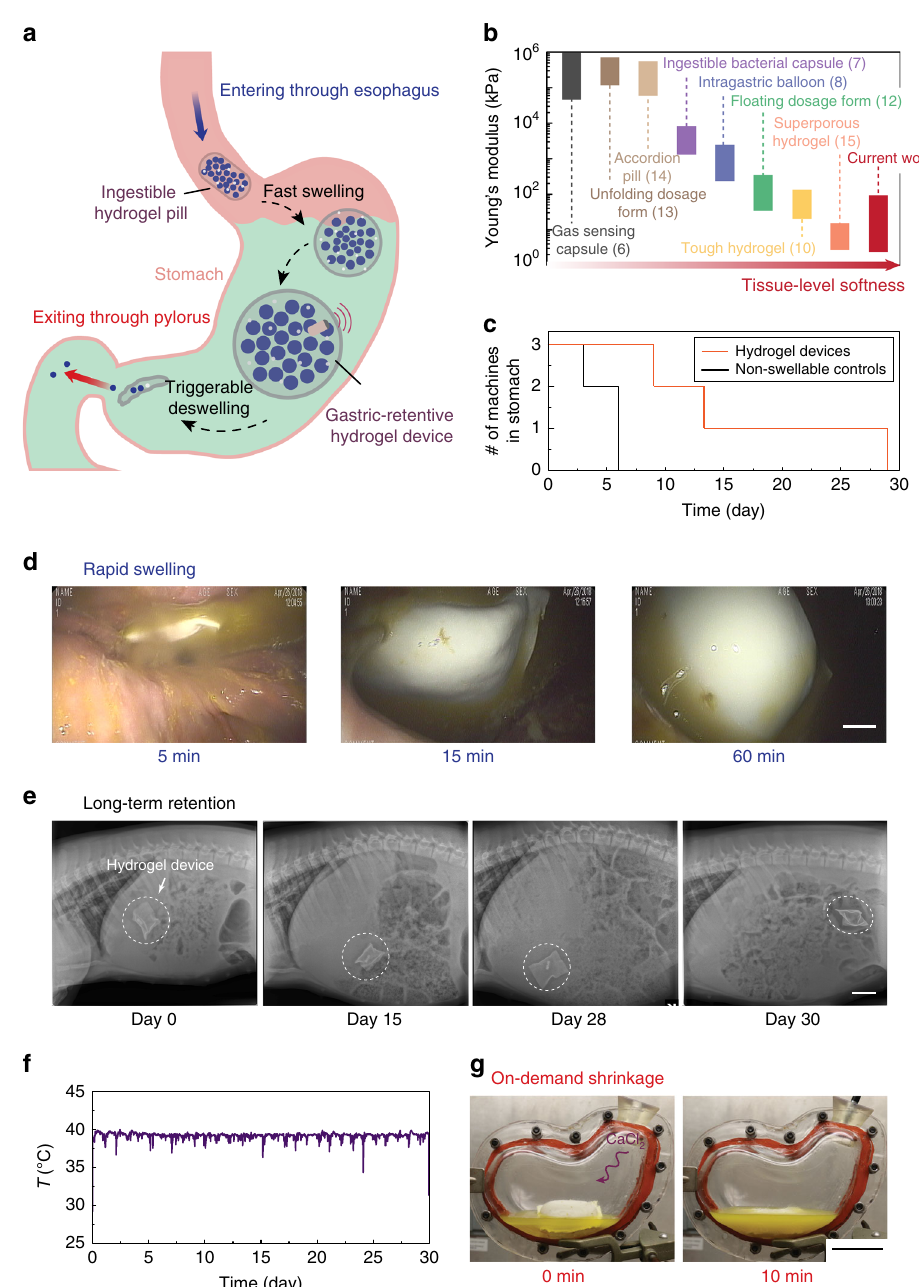
Fig. 4 Long-term gastric retention and physiological monitoring of the ingestible hydrogel device. a Working principle of the gastric-retentive hydrogel device, which enters through the esophagus into the stomach as an ingestible pill, resides in the stomach in its swollen state for a prolonged period of time, and exits through the pylorus as a shrunken capsule and small particles. b Comparison of Young ’ s moduli among recently reported ingestible devices 6 – 8,10,12 – 15 and the hydrogel device in current work. c Number of hydrogel devices and non-swellable devices (i.e., without any superabsorbent particles) being retained in the porcine stomach as a function of time ( N = 3 for each group). d Endoscopic images depicting the swelling of the hydrogel device in the porcine stomach. e X-ray images of the hydrogel device residing in the porcine stomach before being emptied into distal parts of the GI tract (here shown for 29 days in stomach). f Continuous measurement of porcine gastric temperature by a sensor embedded in the hydrogel device. g Photos of ex vivo shrinkage of the hydrogel device triggered by the addition of 0.6 M calcium chloride solution. Scale bars are 10 mm in ( d ), 5 cm in ( e ) and ( g the esophagus into the stomach where it resides in its swollen in the peristaltic and contractile stomach without being evacuated state for a prolonged period of time. As depicted in Fig. 4d and through the pylorus for a long time (9 – 29 days; Fig. 4c, e and Supplementary Figure 12, the hydrogel device with the initial Supplementary Table 1). During its residency in the stomach, the size of ~3 cm 3 (diameter of 1 cm and length of 3 cm, compatible hydrogel device fl oated freely with no radiographic or clinical with oral administration) absorbed gastric fl uid and swelled to evidence of bowel obstruction. In contrast, control samples of the ~50 cm 3 within 60 min in the porcine stomach. Radiographic non-swellable hydrogel device with no superabsorbent particles data suggested that it retained its swollen shape and dimensions (but otherwise identical design to the original hydrogel device)